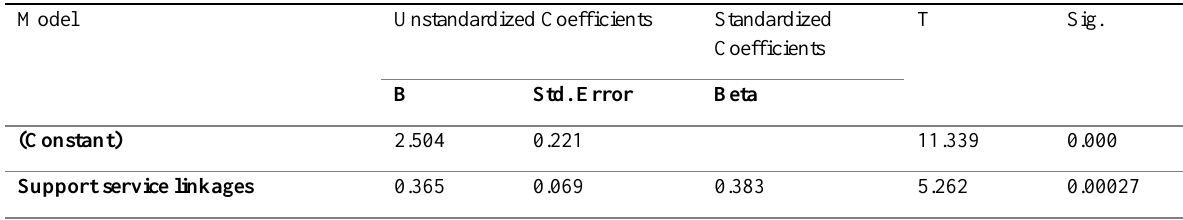
Table 8: Mathematical model for support service linkages and sustainability of DFLPs